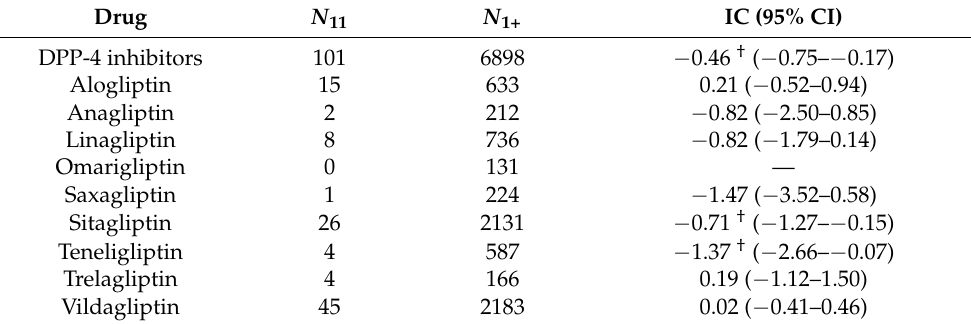
Table 4. The signal scores of each dipeptidyl peptidase-4 (DPP-4) inhibitor.